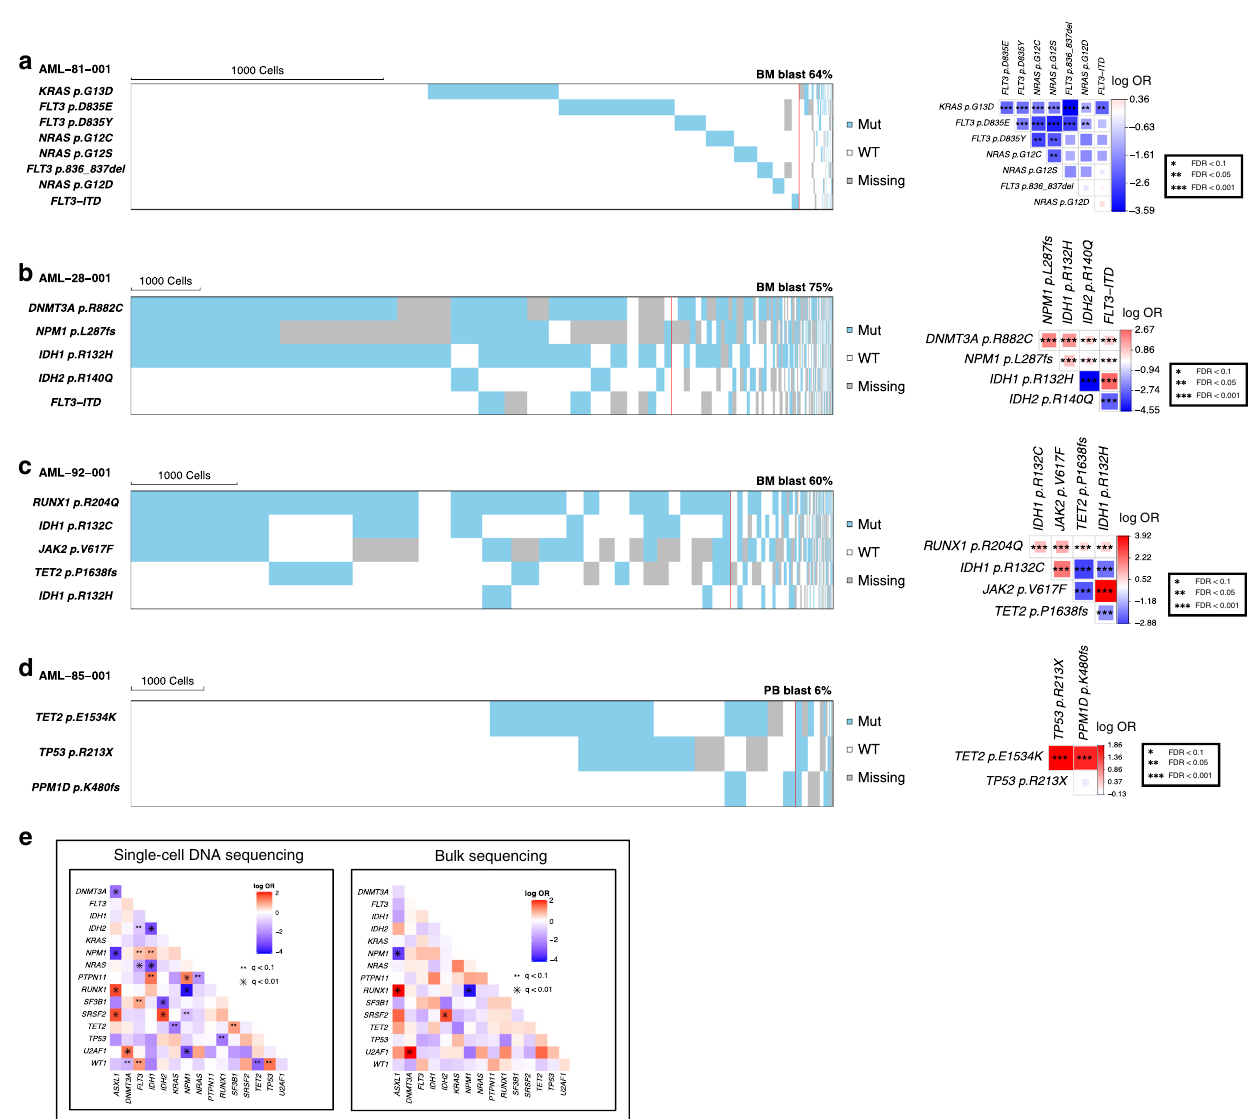
Fig. 2 The cellular-level mutual exclusivity of AML driver mutations. a – d Cell-level mutual exclusivity patterns of driver mutations in individual samples for four representative cases. a KRAS , NRAS , FLT3 -non-ITD, and FLT3 -ITD, b IDH1 and IDH2 , c IDH1 p.R132C, IDH1 p.R132H, and TET2 , d TP53 and PPM1D variants did not co-occur in the same cellular populations. Mut mutated, WT wild type, Missing missing genotype. Heat maps (left) show the genotype of each sequenced cell for each variant, with clustering based on the genotypes of driver mutations. Each column represents a cell at the indicated scale. Cells with mutations and wild-type cells are indicated in blue and white, respectively. Cells with missing genotypes are indicated in gray. The subclones located to the right of the red line comprised <1% of the total sequenced cells, and such small subclones can represent false positive or negative genotypes as a result of allele dropout or multiplets. The fi gures on the right show the pairwise association of mutations. The color and size of each panel represent the degree of the logarithmic odds ratio (log OR). The bar on the right side is a key indicating the association of the colors with the log OR. Co-occurrence and mutual exclusivity are indicated by red and blue, respectively. The statistical signi fi cance of the associations based on the false discovery rate (FDR) is indicated by the asterisks (*FDR < 0.1, **FDR < 0.05, ***FDR < 0.001). e Pairwise association of driver mutations in AML based on single-cell DNA sequencing (left) and bulk sequencing data (right). For each pair of mutations, their dependency was summarized as log OR, with positive values (red) indicating a degree of co-occurrence and negative values (blue) indicating a degree of mutual exclusivity. The statistical signi fi cance of the associations based on the q value is indicated by the dots and asterisks ( ** q < 0.1, * q < WT1 , and TET2 were often found to carry two different provide cell-level evidence of mutation co-occurrence, which mutations co-occurring in the same cells, which is consistent not only validates previous fi ndings by bulk-sequencing studies with the previously reported biallelic involvement of these but also corrects previously mischaracterized relationships (e.g., tumor suppressor genes (Supplementary Fig. 8c) 16 – 18 . Pair-wise TP53 and PPM1D ). analysis of mutation co-occurrence using pooled single-cell data identi fi ed more signi fi cant co-occurrence and mutually exclusive relationships among AML driver genes compared to the same analysis using bulk-seq data from the same samples (Fig. 2e). Taken together, these single-cell genotype data